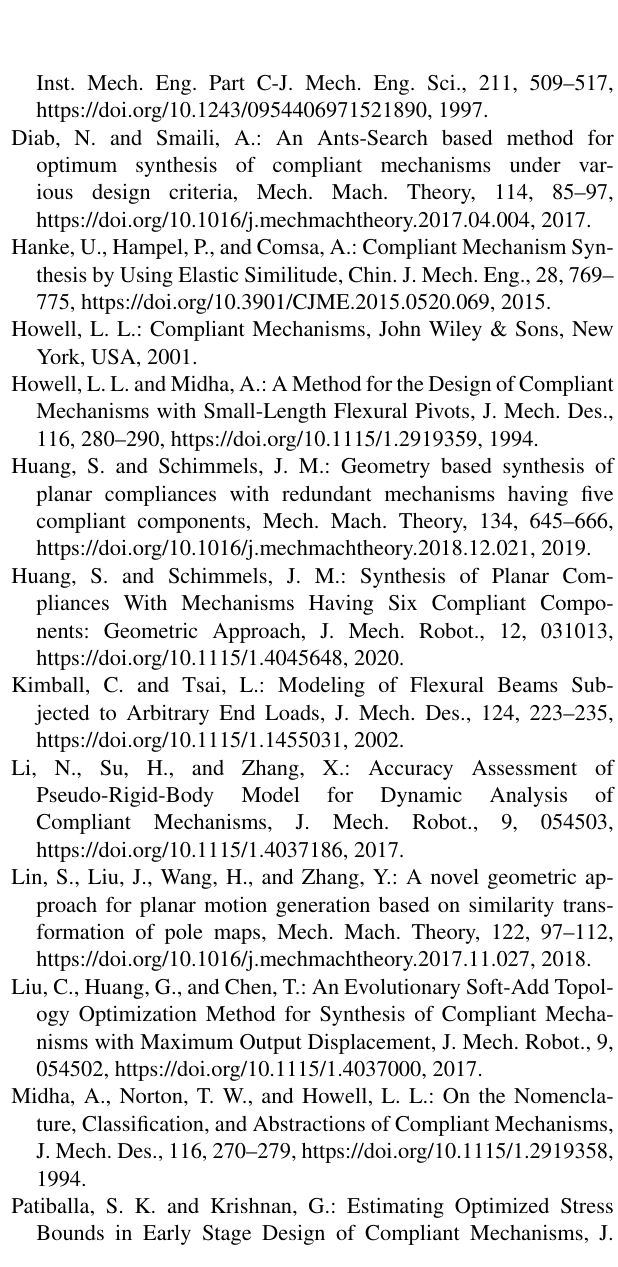
Figure 20. Relationship between guidance order and pole